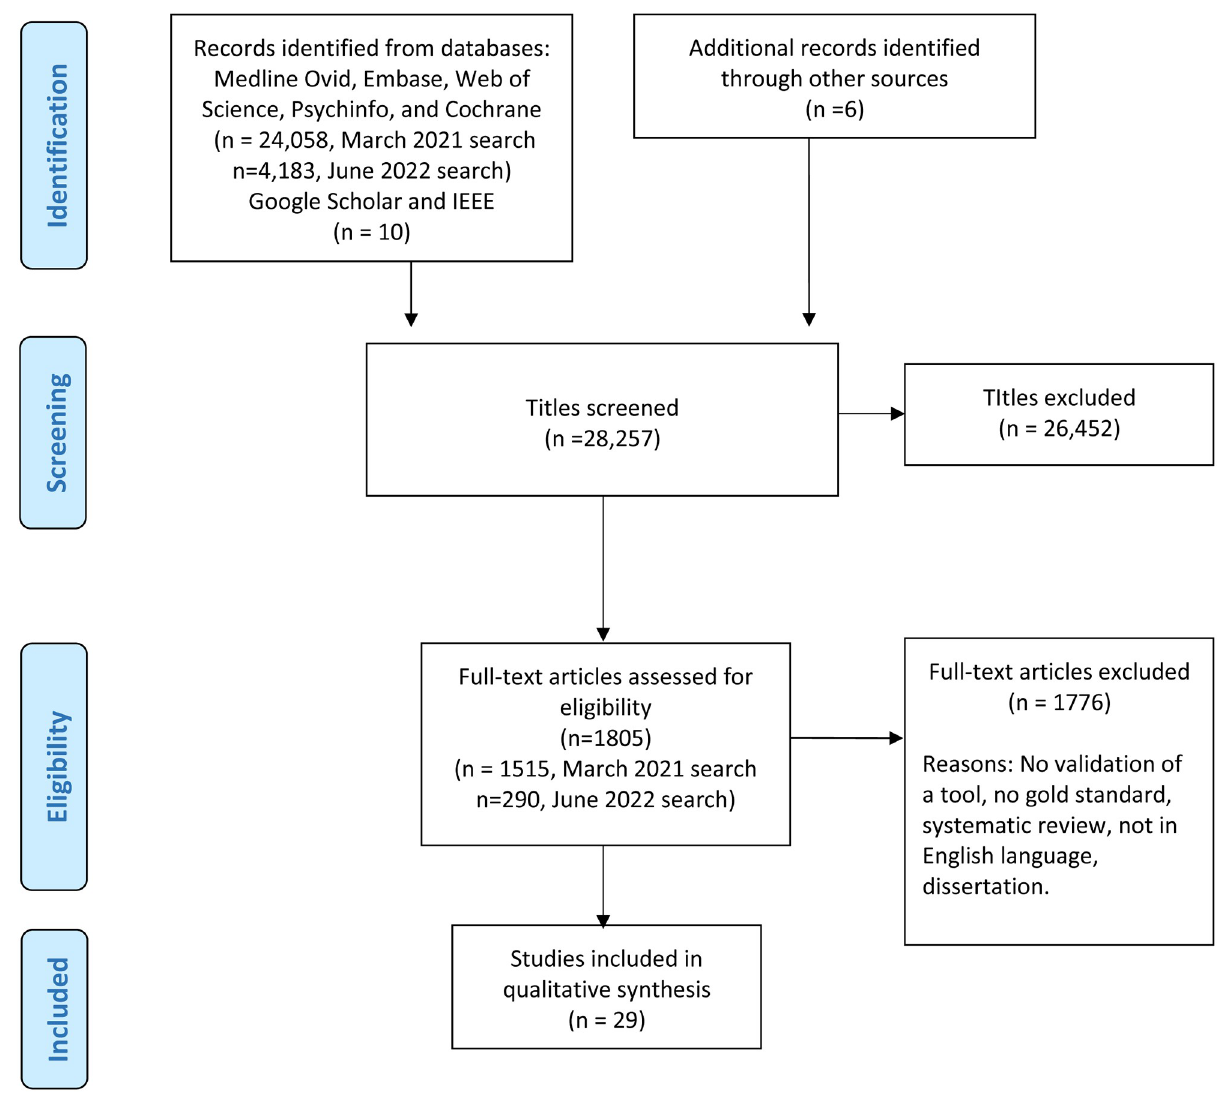
Fig 1. PRISMA flow